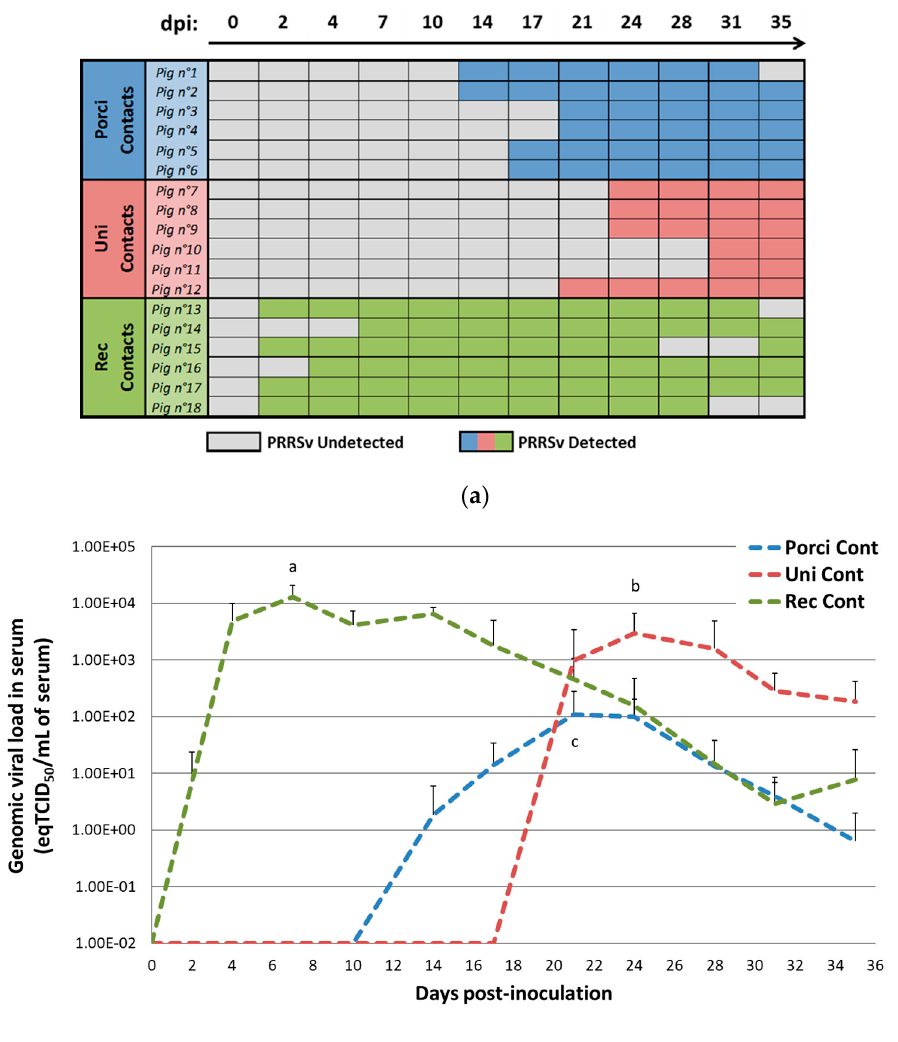
Figure 3. Porcine Reproductive and Respiratory Syndrome Virus (PRRSV) detection and genomic viral load in serum from contact pigs. ( a ) Detection of genomic viral loads in the serum of contact animals from the Porci, Uni, and Rec groups: individual detection data. ( b ) Evolution of the mean viremia in contact pigs after inoculation (day 0) (equivalent TCID 50 /mL of serum). Different letters (a, b, c) indicate that the groups are significantly different from each other at viremia peak with p ≤ 0.05.